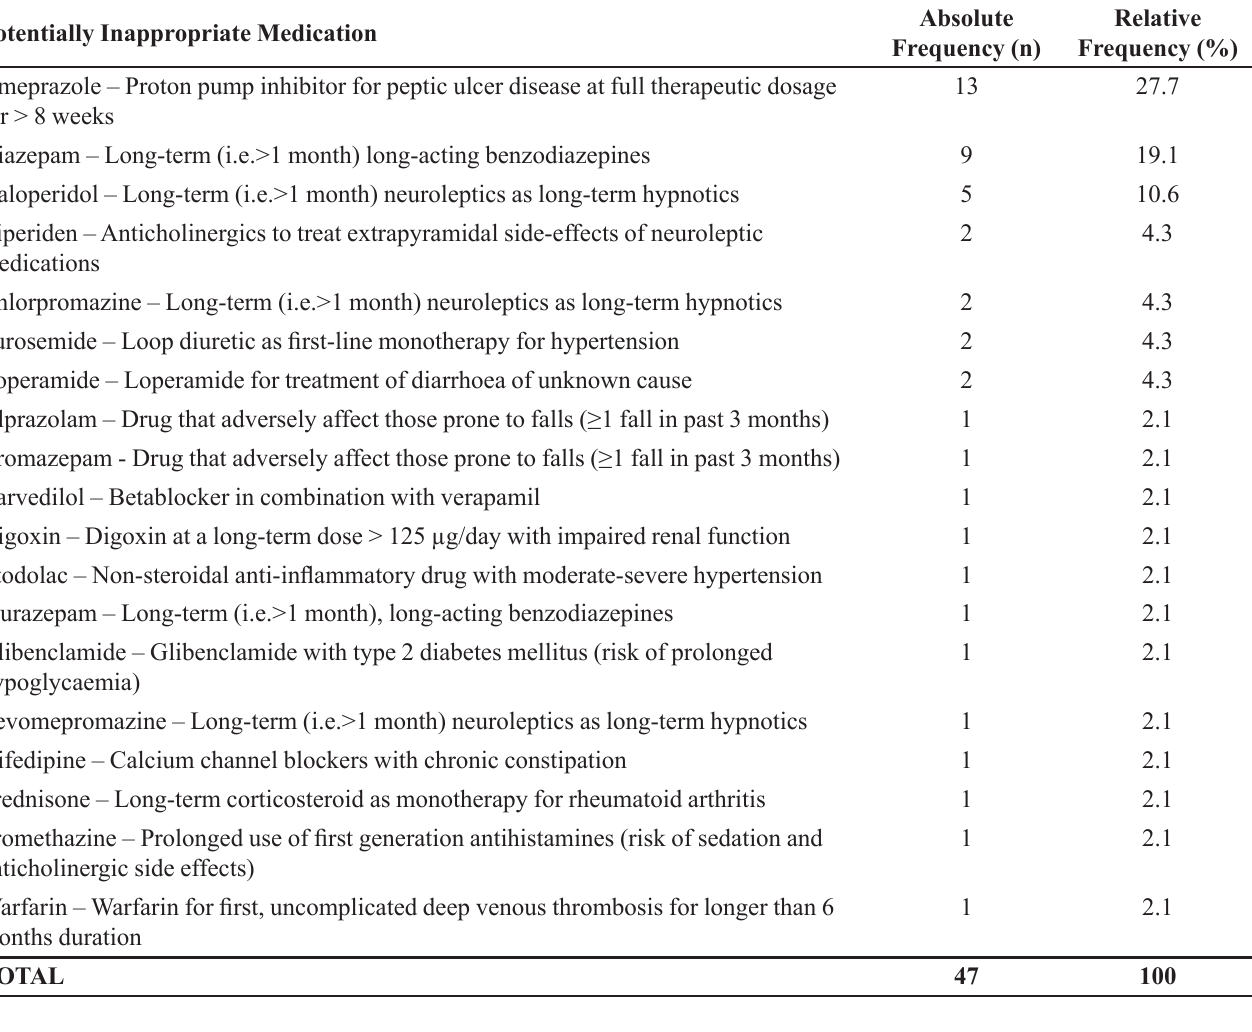
TABLE III - Association with PIM use